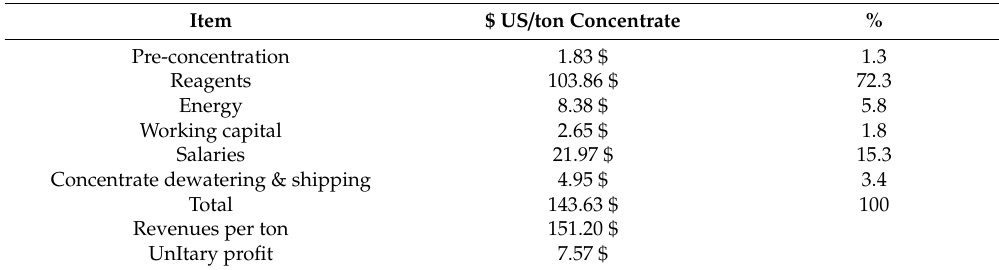
Table 11. Estimated operating costs [18] for the apatite concentration circuit from the CC (reagent and energy prices are those of